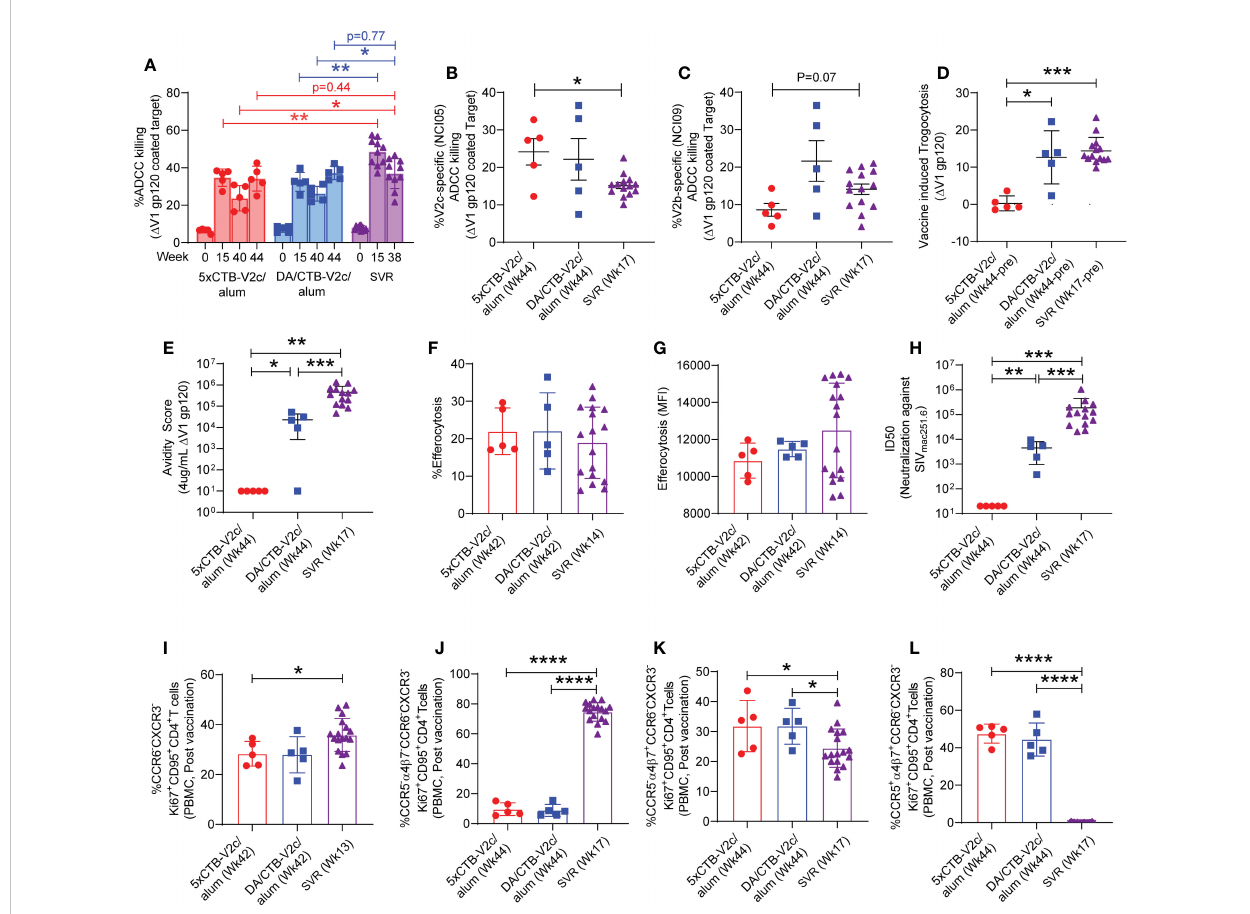
FIGURE 3 Comparison of non-neutralizing antibody, neutralizing antibody, efferocytosis and Th2 cell response among different vaccine group of macaques. (A) Longitudinal percent ADCC killing in animals vaccinated with different vaccine regimens. (B, C) Comparison of V2-speci fi c ADCC killing among 3 groups of vaccinated animals before challenging with SIV mac251 . Comparison of (D) Trogocytosis against D V1 gp120, (E) avidity score against D V1 gp120, (F) percentage efferocytosis, (G) Efferocytosis MFI, (H) Neutralizing antibody, (I) Th2 cells, (J) CCR5 - a 4 b 7 - Th2 cells, (K) CCR5 - a 4 b 7+ Th2 cells, and (L) CCR5 + a 4 b 7+ Th2 cells among 5xCTB-V2c/alum, DA/CTB-V2c/alum and SVR vaccinated animals. Data shown in (A – L) were analyzed with the Mann-Whitney U test or Wilcoxon signed-rank test. Horizontal and vertical bars denote mean and SD, respectively. Red circles indicate 5xCTB-V2c/alum vaccinated macaque group, blue squares indicate DA/CTB-V2c/alum vaccinated macaque group, purple triangles indicate SVR group (2xDNA, 1xALVAC-SIV, 1xALVAC-SIV + D V1 gp120/alum boost). *p < 0.05, **p < 0.01, ***p < 0.001, ****p <